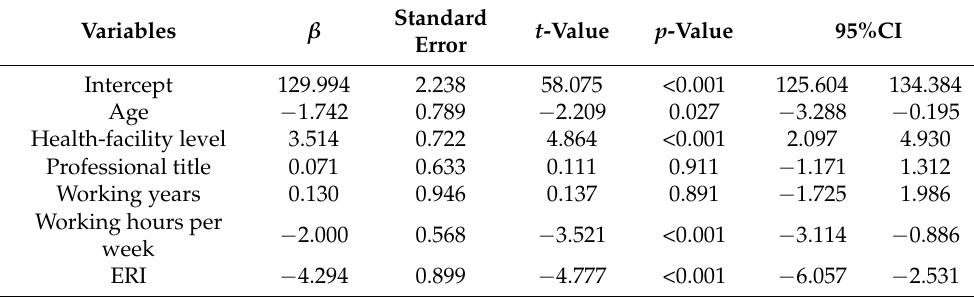
Table 6. Exploration of factors influencing the physical health of medical staff.